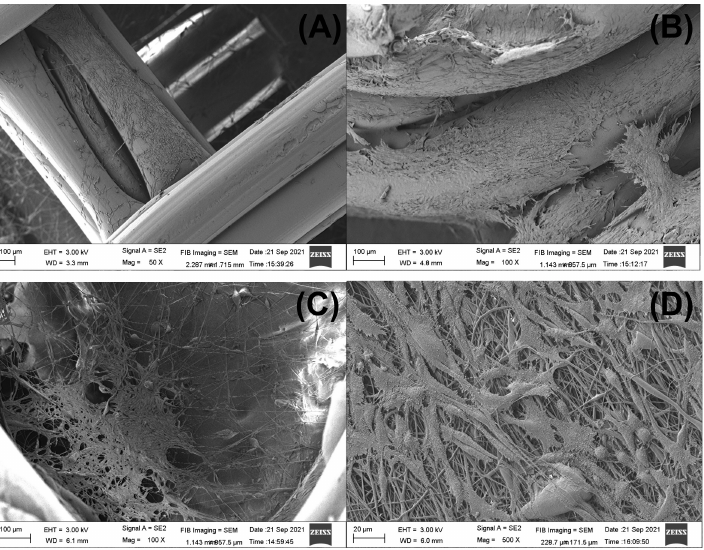
Figure 13. Selected SEM images of 3D-printed/electrospun composites cultured for 5 days with 3T3 cells. Fibroblast adhered to the 3D-printed piece are showed in ( A , B ). (( A ) is a square 3D-printed/electrospun composite with PLA10 fibers, and ( B ) is the ellipsoidal composite with PLA/PEG/5.0HA fibers). The fibroblasts which adhered to the fibrous layer of the composite are showed in ( C , D ). (( C ) is an ellipsoidal composite with PLA10 fibers, and ( D ) is a square composite with PLA/PEG/5.0HA